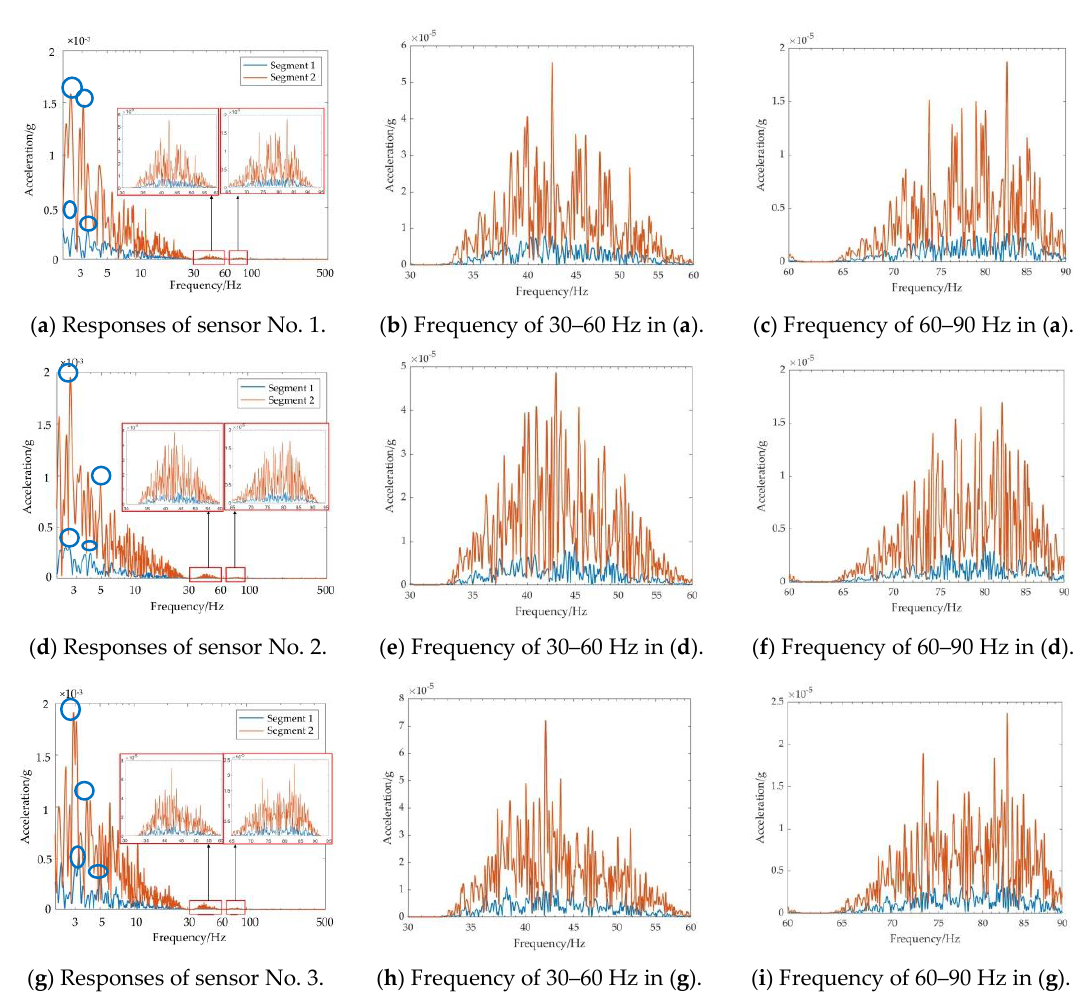
Figure 13. Frequency-domain responses of Segment 1 and Segment 2.